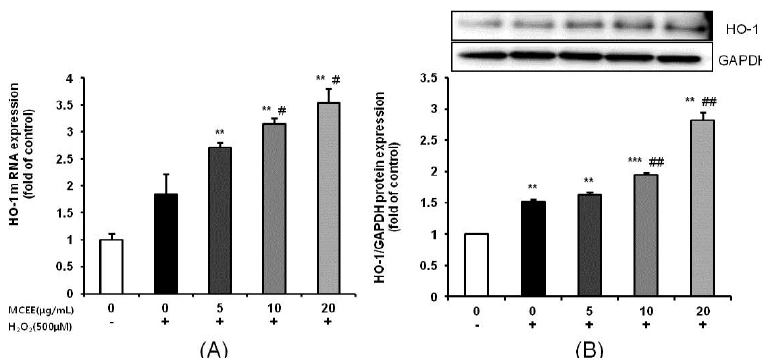
Figure 3. Effects of MCEE on ( A ) superoxide dismutase (SOD) activity, ( B ) reduced glutathione (GSH), and ( C ) malondialdehyde (MDA) levels in H 2 O 2 -treated cells. Cells were pretreated with the MCEE for 24 h and then treated with H 2 O 2 for 4 h. Data are shown as means ± S.D. ( n = 3). * p < 0.05; ** p < 0.01; *** p < 0.001 compared with the untreated control cells, # p < 0.05; ### p < 0.001 compared with only H 2 O 2 -treated cells.